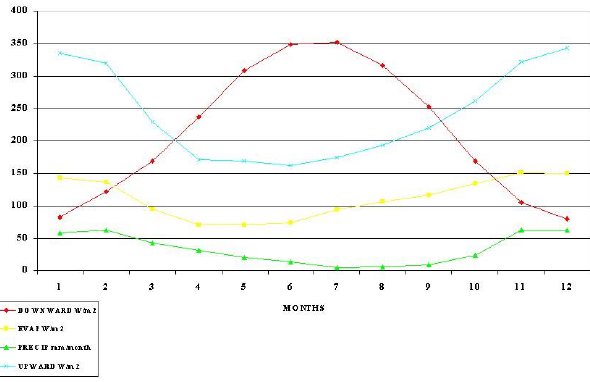
Fig. 5a. ECMWF surface forcing in the NE CYCOM model domain: annual cycle of downward and upward heat fluxes, precipitation and evaporation.